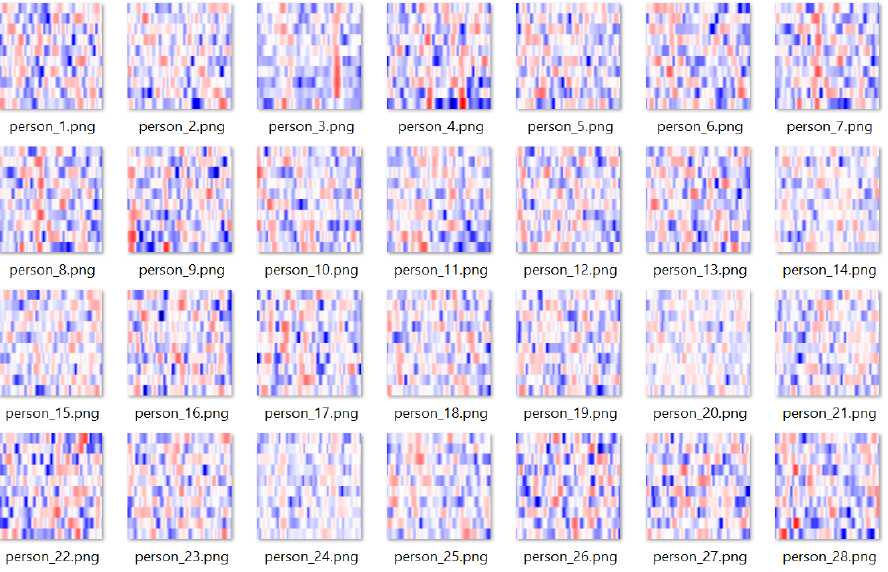
Figure A2. A set of pictures (TFR using Morlet wavelets) for stress for each participant—averaged values from all